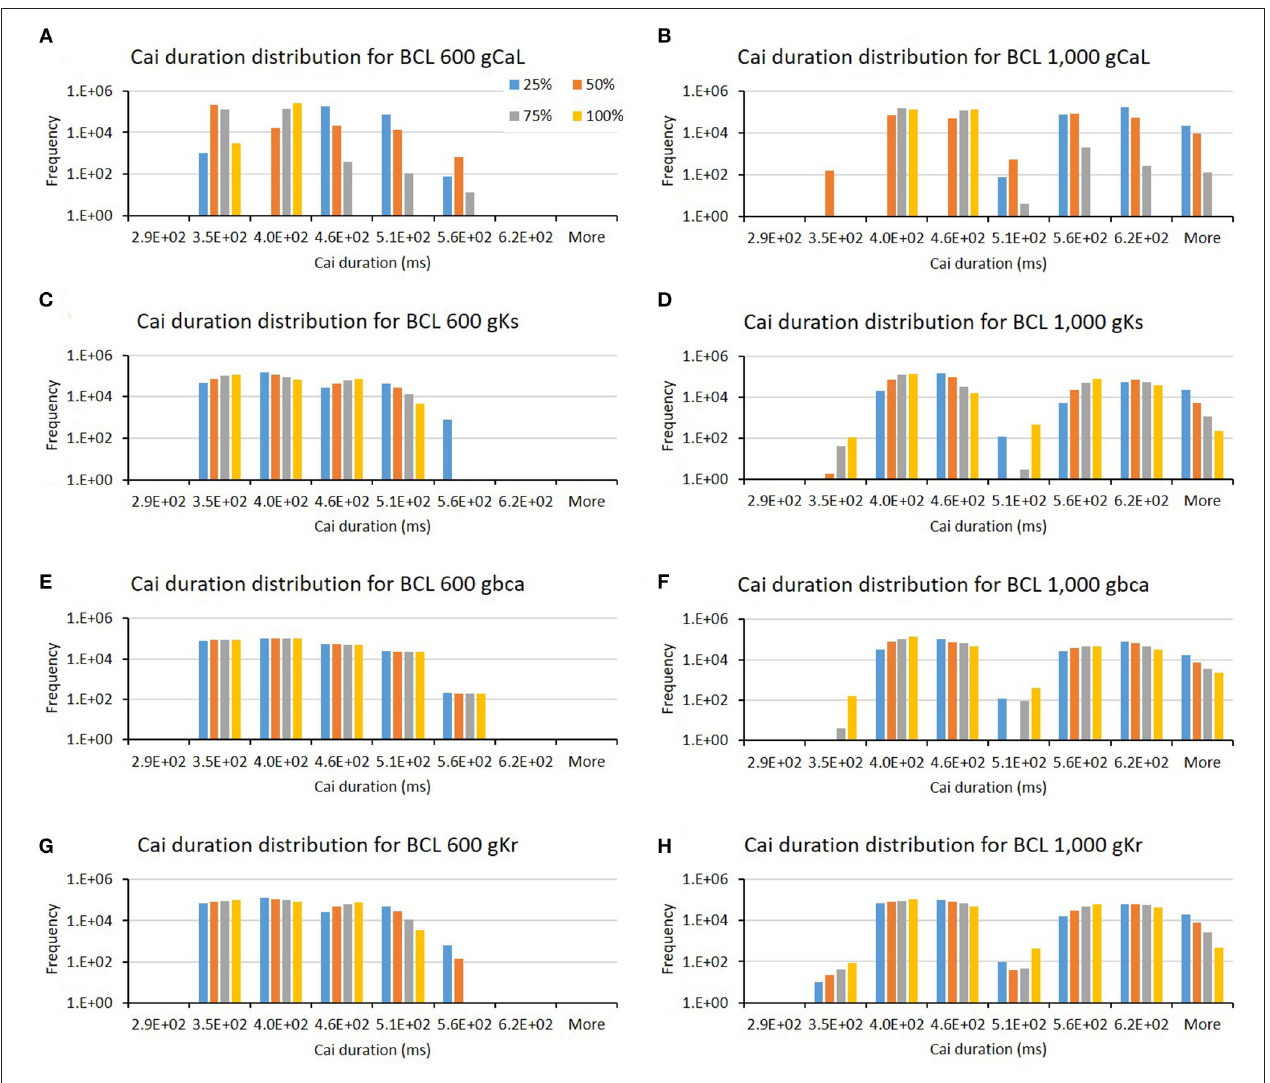
FIGURE 9 | The bar charts show the influence of major ion channels (based on Table 1 ) for altering the Cai duration [for BCL 600ms (A,C,E,G) and for BCL 1,000ms (B,D,F,H) ]. The x-axis is the Cai duration groups in milliseconds, and the y-axis is the frequency (number of appearance of Cai duration groups) in logarithmic scale. Four conductance variations are applied